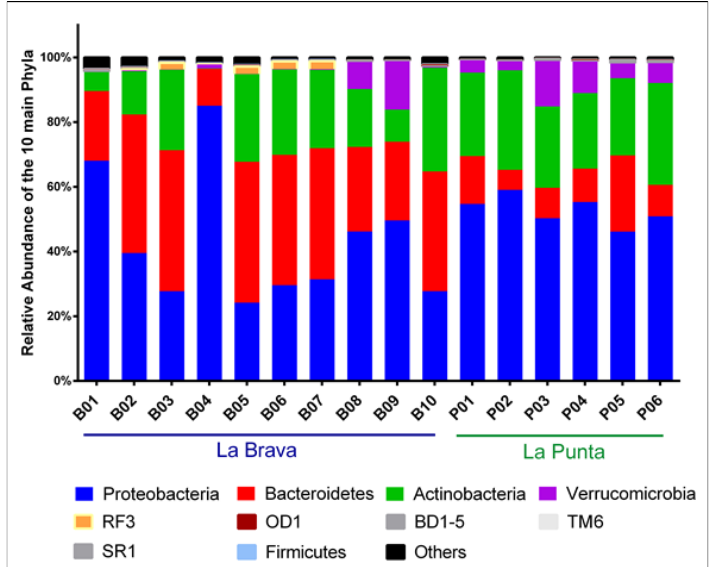
Figure 3. Microbial community composition of the sampling points from La Brava and La Punta lakes.